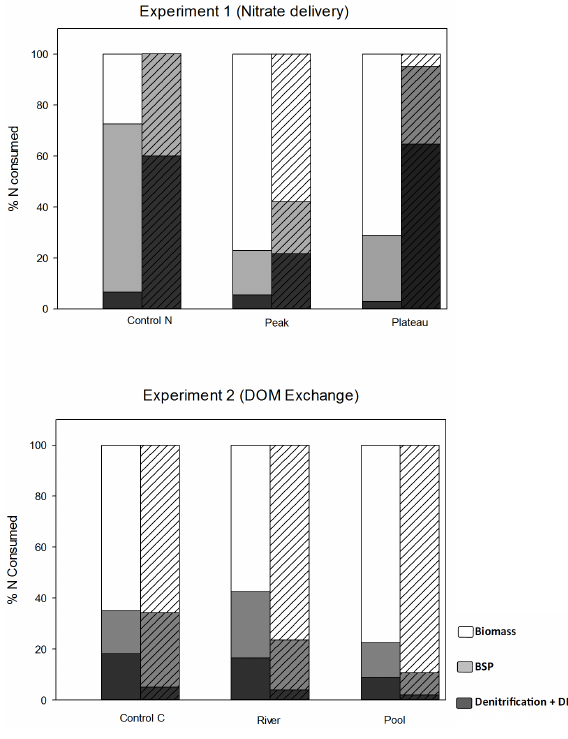
Fig. 5. Estimated percentage of total N pool used by denitrifica- Figure 5. Estimated percentage of total N pool used by denitrification and DNRA (dark gray), tion and DNRA (dark gray), bacterial secondary production (middle bacterial secondary production (middle gray) and biomass assimilation (light gray) using gray) and biomass assimilation (light gray) using the five-day aver- the 5 days averages. Solid bars are estimates from the disconnected site, hashed bars ages. Solid bars are estimates from the disconnected site, hashed from the restored site. N=3 bars from the restored site. N =